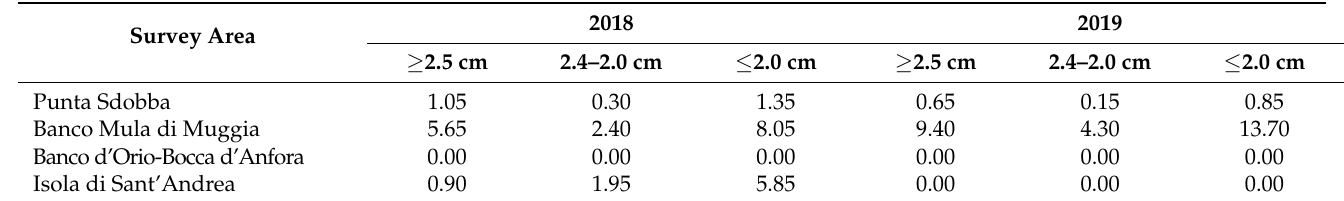
Table 6. Biomass (mean value; g/m 2 ) of Chamelea gallina (divided by size as shell total length; cm) recorded during surveys carried out in the years 2018 and 2019